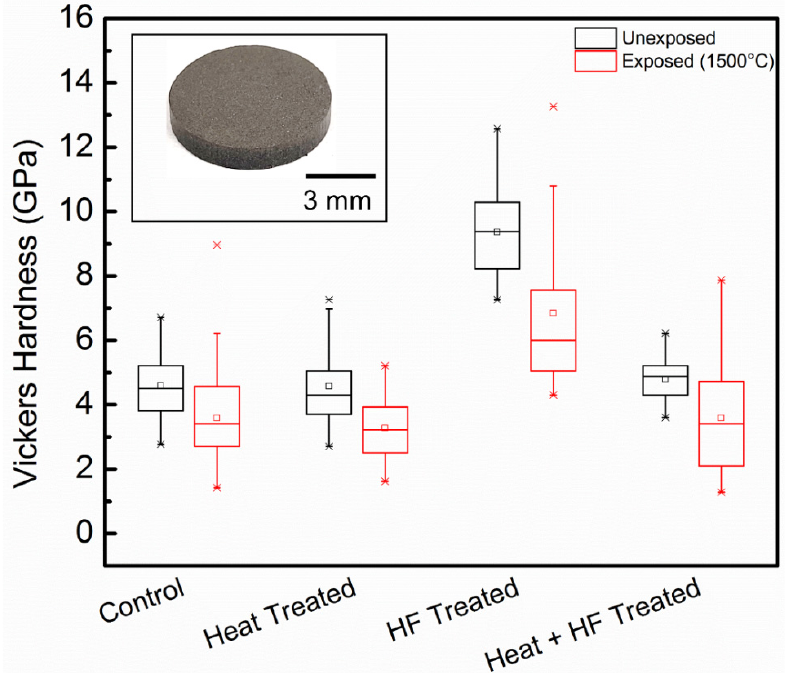
Figure 8. Vickers hardness of control pellets and pellets synthesized using pretreated powders. HF treated powders result in pellets with nearly double the hardness value both when synthesized at 850 °C and when exposed to 1500 °C. Image of a typical pellet is shown in the inset.